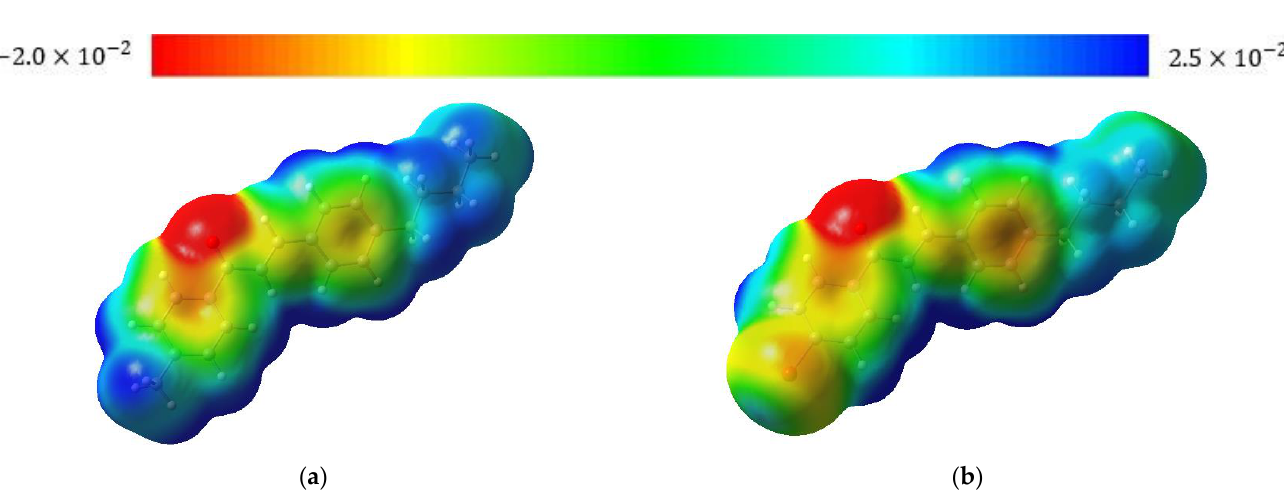
Figure 7. MEP surface at ρ(r) = 4.0 × 10 − 4 electrons/Bohr 3 contour of the total SCF electronic density for ( a ) BMP and ( b ) BBP at the M06-2X/6-311++G(d,p) level of theory.